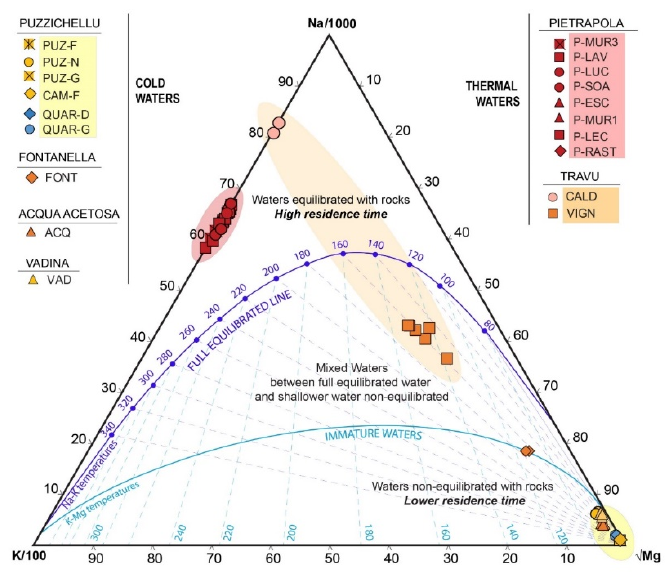
Figure 8. Distribution of thermo-mineral springs water on a Na-K- √ Mg Giggenbach diagram [54], which allows determining reservoir temperature and equilibration status of rock with water. The spring group of Pietrapola is displayed in red background while Puzzichellu is displayed in yellow background and the Travu River Valley in orange background.